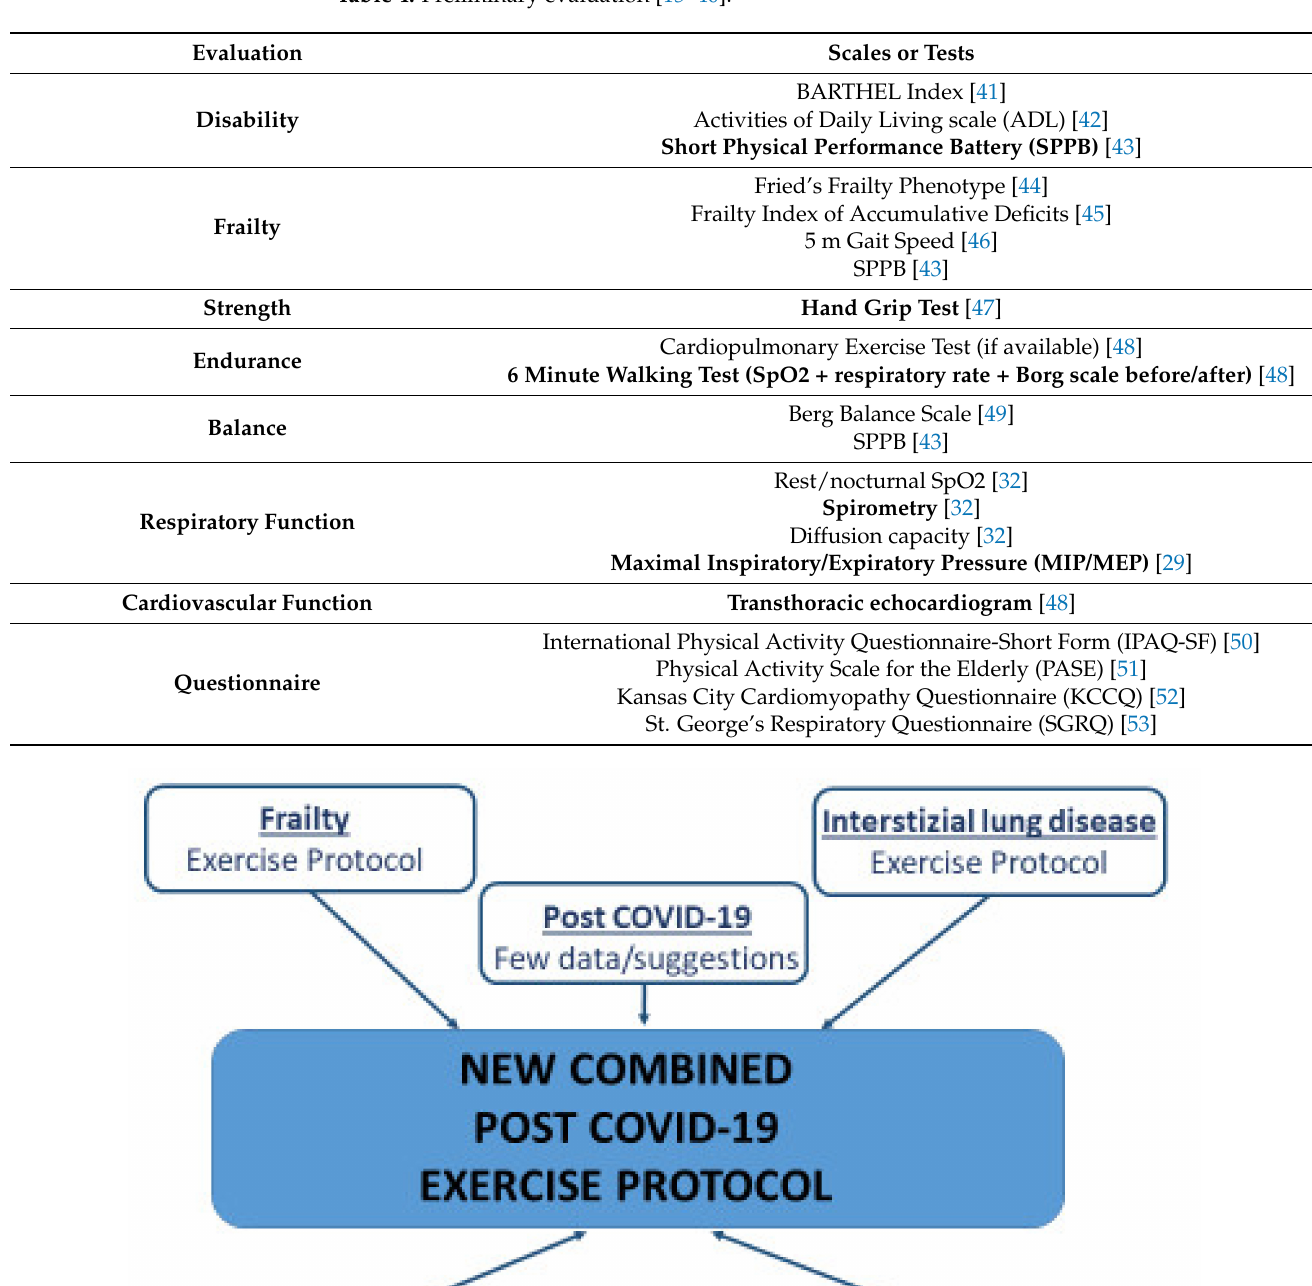
Table 4. Preliminary evaluation [15–40].